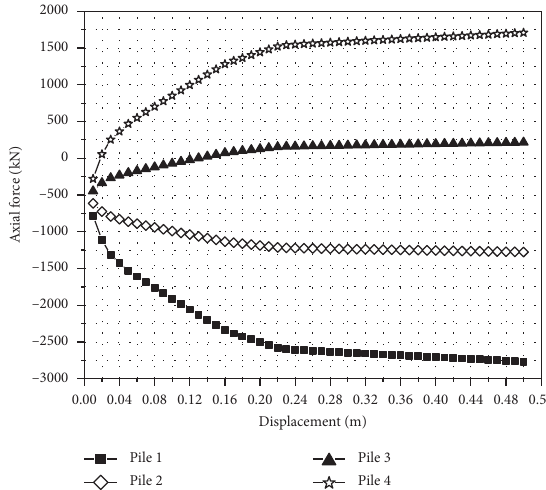
Figure 37: Axial force-displacement at the top of piles 1–4.